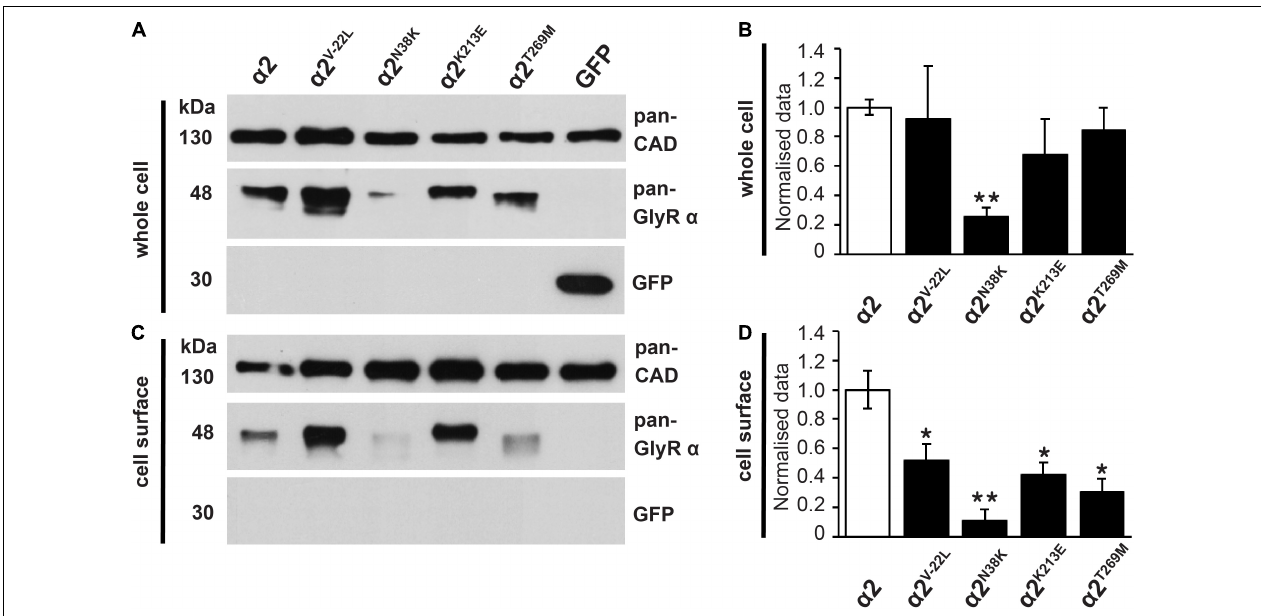
FIGURE 5 | Whole-cell protein and cell-surface expression of GlyR α 2 subunit variants. (A,C) Whole-cell protein and cell-surface protein fractions from HEK293 cells transfected with either wild-type GlyR α 2 or GlyR α 2 variants α 2 V - 22L , α 2 N38K , α 2 K213E , or α 2 T269M were immunostained for GlyR α 2 using the pan-GlyR α subunit antibody mAb4a (48 kDa). For cell-surface biotinylation assays, cells were also transfected with EGFP as an internal control to ensure that only cell-surface proteins (30 kDa) were isolated. Cadherin served as housekeeping protein for both whole-cell and cell-surface expression and was detected by a pan-cadherin (pan-CAD) antibody (130 kDa). (B,D) Quantification of whole-cell and cell-surface protein fractions, normalized to pan-cadherin. The expression of wild-type GlyR α 2 subunit was set to 1 (reflecting 100%). We noted a significant reduction of cell-surface protein for all GlyR α 2 variants compared to the wild-type GlyR α 2 control; significance values are * p < 0.05, ** p < 0.01. All results are detailed in Table 1